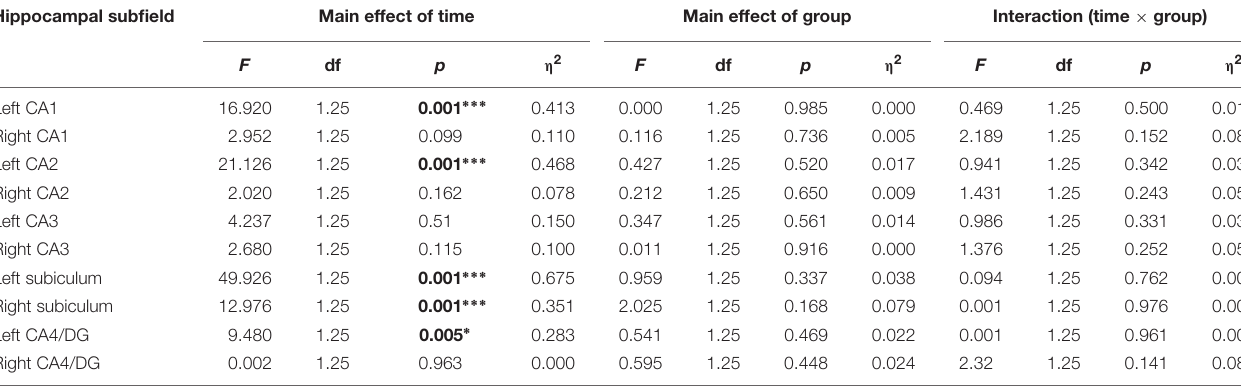
TABLE 2 | Statistical values of repeated-measures ANOVAs for hippocampal subfields.